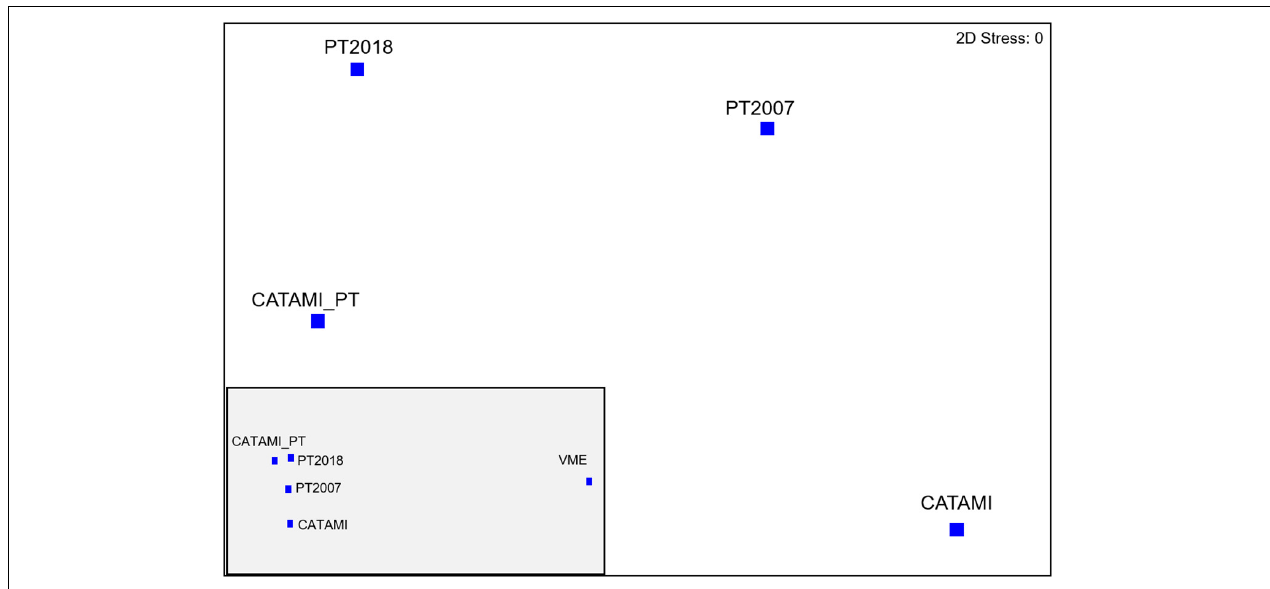
FIGURE 8 | Second-stage nMDS , showing the concordance in community patterns between the five classification schemes